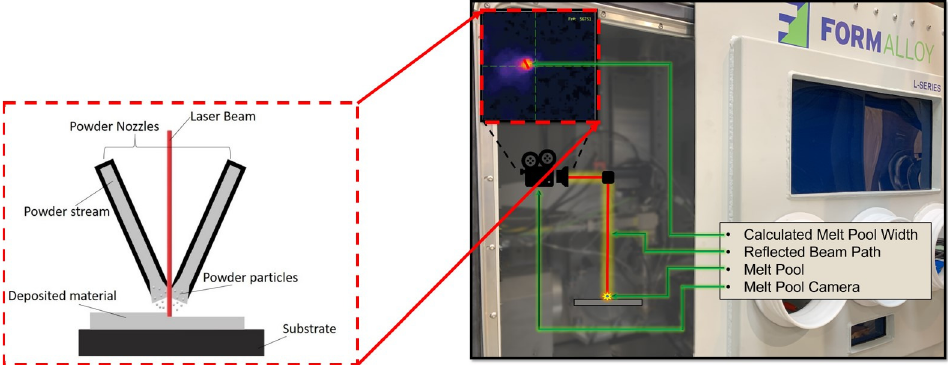
Figure 1. Schematic of FormAlloy L2 metal AM system with MPS